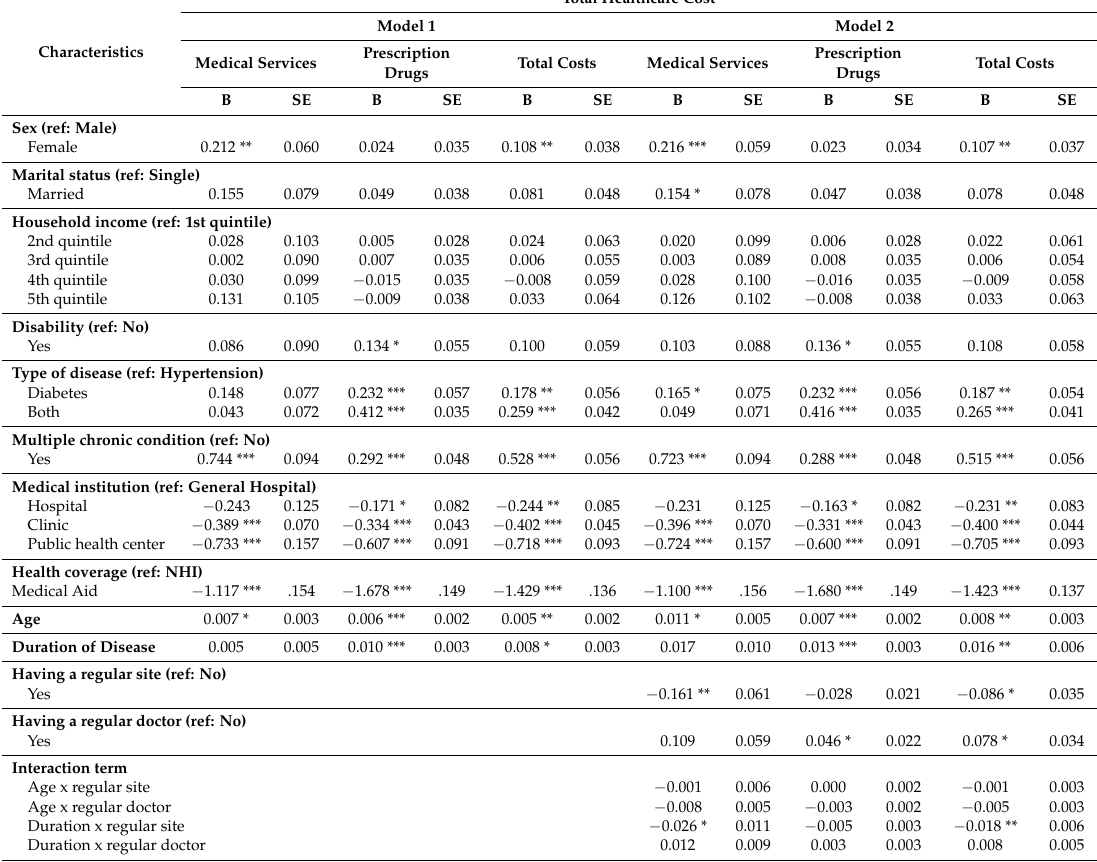
Table 3. The results of generalized estimation equation (GEE) analysis for total healthcare